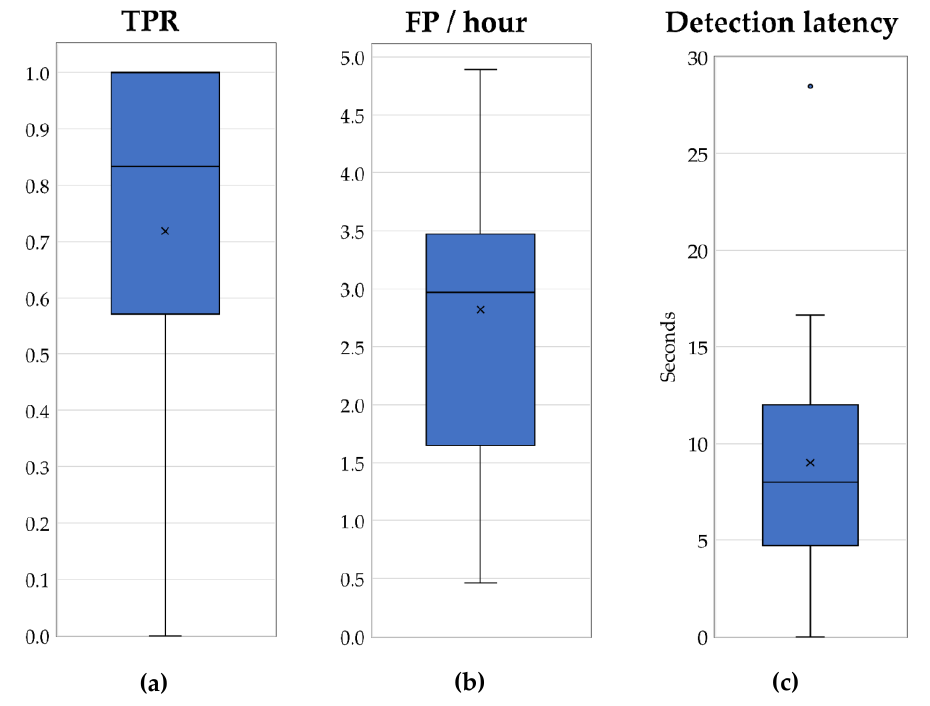
Figure 6. Temporal performance of the proposed algorithm: ( a ) TPR, ( b ) FP/hour, and ( c ) detection latency. Table 4. Overall temporal performance.